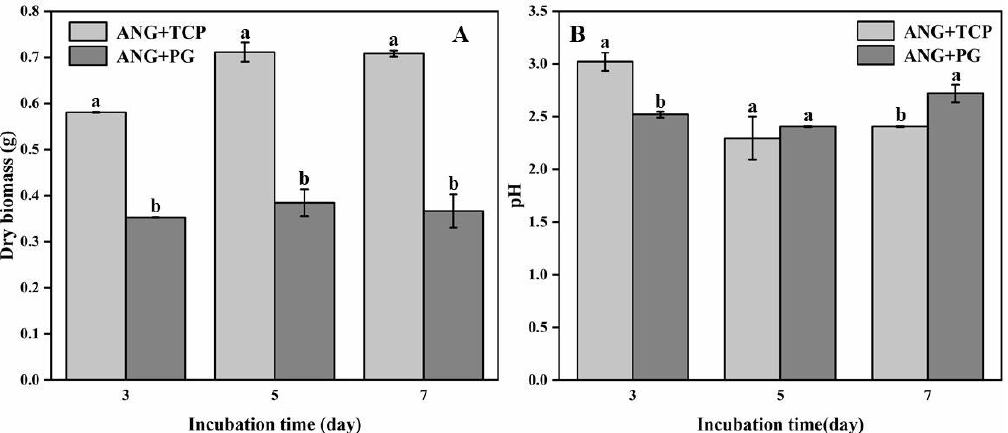
Figure 1. The dry biomass of A. niger ( A ) and pH value ( B ) between ANG + TCP and ANG + PG treatments during incubation (3, 5, 7 days). The different lower-case letters indicate a significant difference between the treatments ( p < 0.05). The significant differences among the treatments were identified by the Tukey test ( p < 0.05).